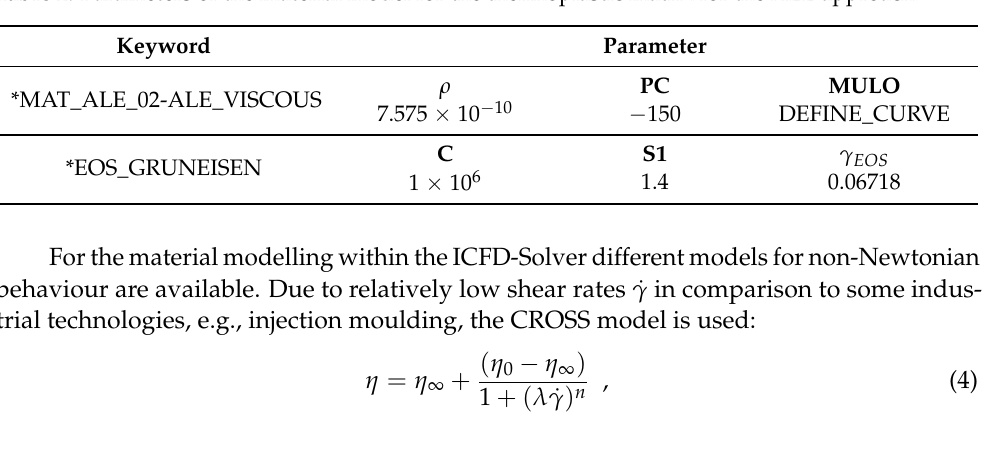
Table 2. Parameters of the material model for the thermoplastic matrix for the ALE